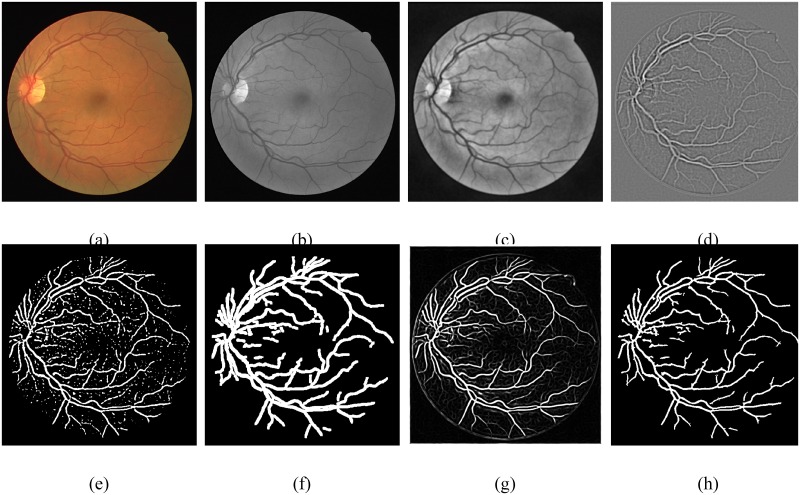
Visual presentation of the proposed system major processing stages.(a) Input RGB photograph from DRIVE database (b) Green channel (c) CLAHE applied result (d) Difference image (e) Otsu threshold resultant image (f) Postprocessed dilated image (g) Frangi filter enhanced image (h) Final image using AND Operation.